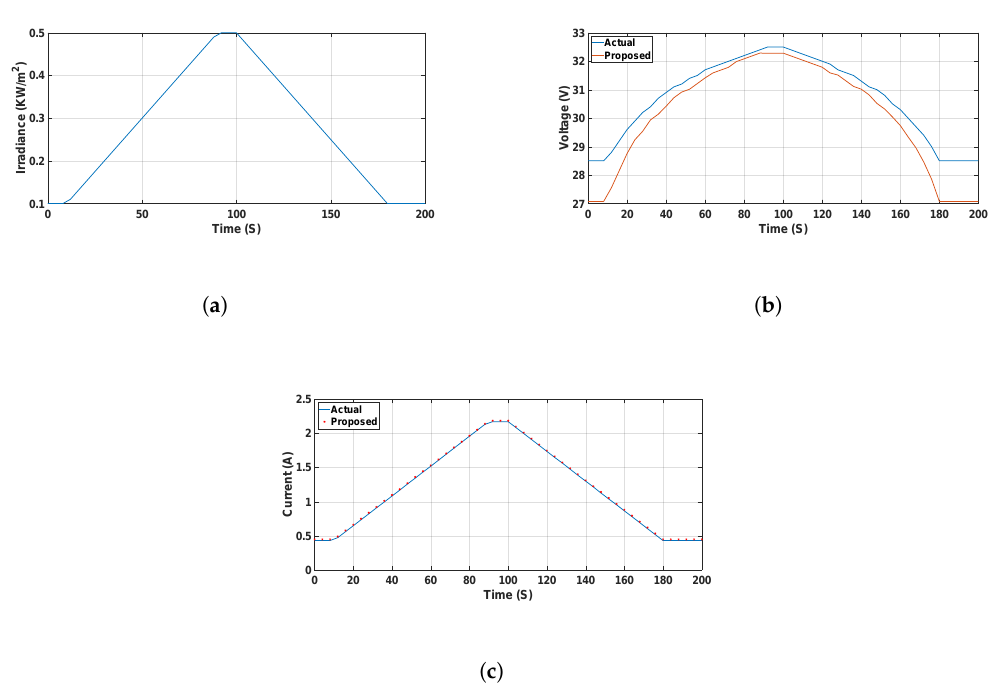
Figure 11. ( a ) Irradiance at a gradient of 5 W/m 2 /s ( b ) accuracy of the Proposed algorithm in finding V mpp at 5 W/m 2 /s gradient ( c ) accuracy of the Proposed algorithm in finding I mpp at 5 W/m 2 /s gradient.